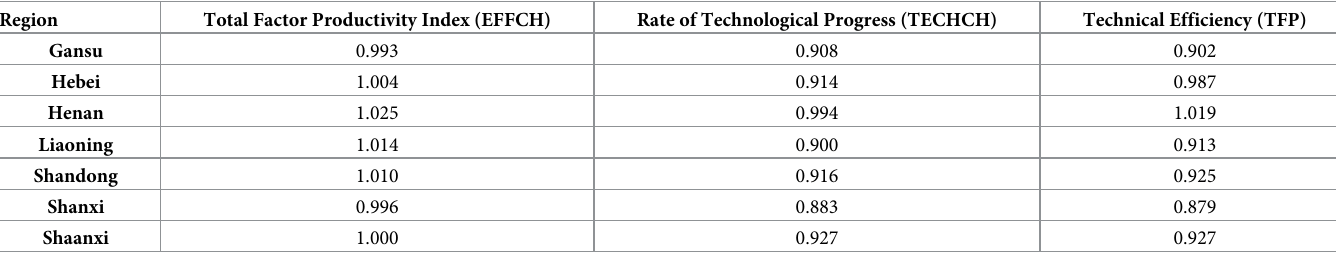
Table 2. Average value of TFP and its components in the seven main apple-producing areas from 2008–2018. Region Total Factor Productivity Index